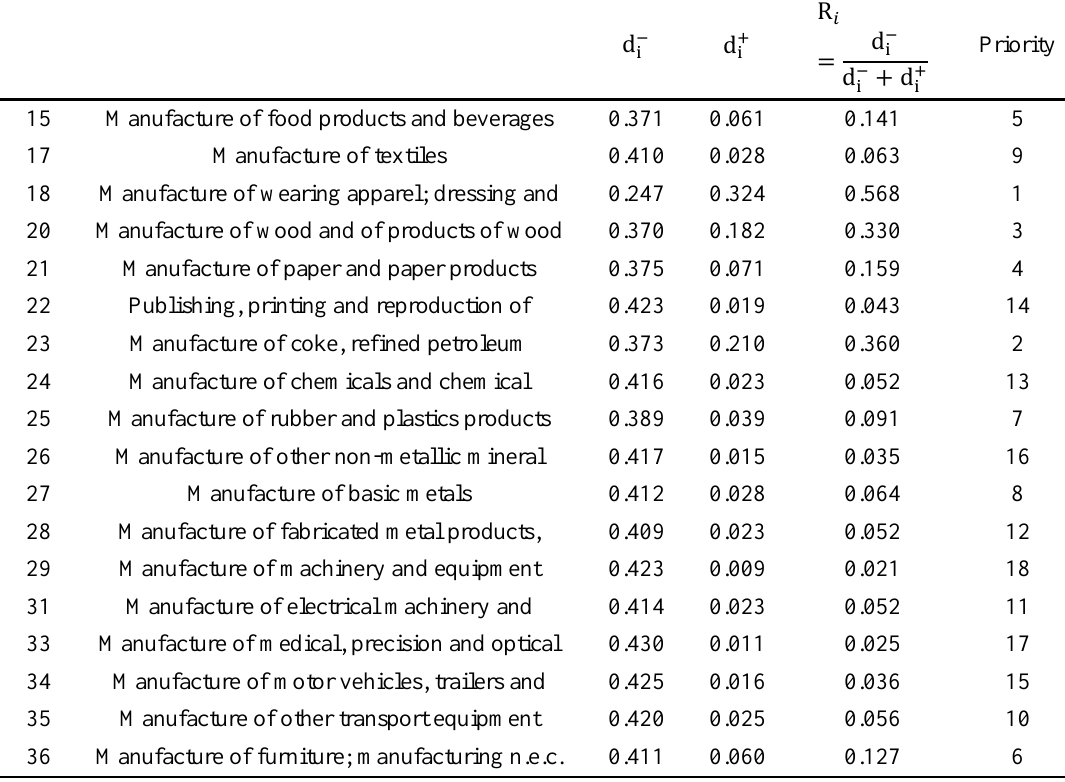
Table 3. Proposed projects priority for performing with TOPSIS.